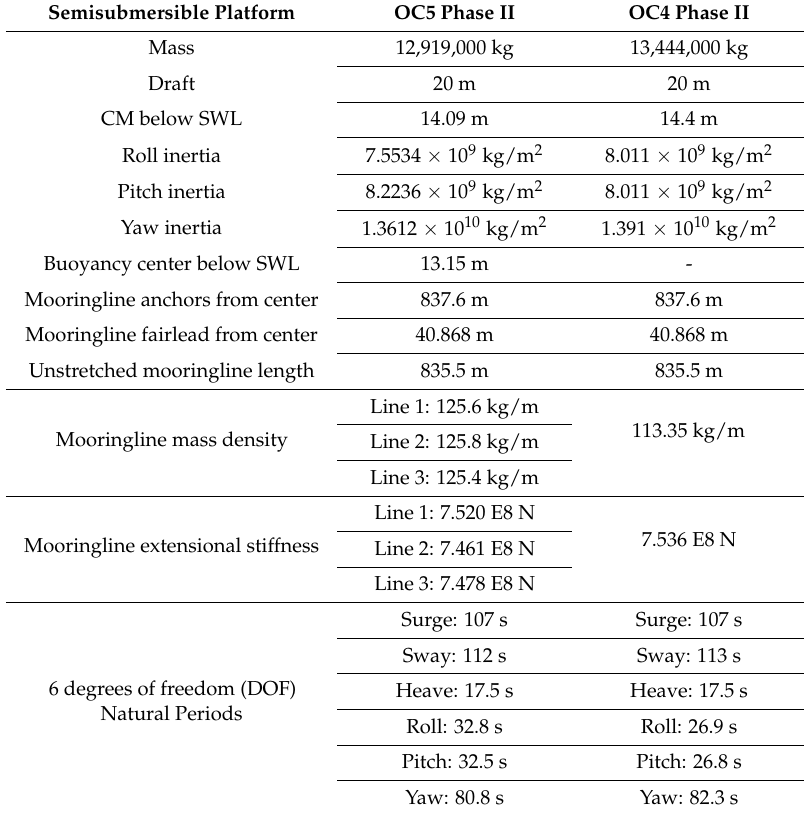
Table 4. Comparison of OC4 and OC5